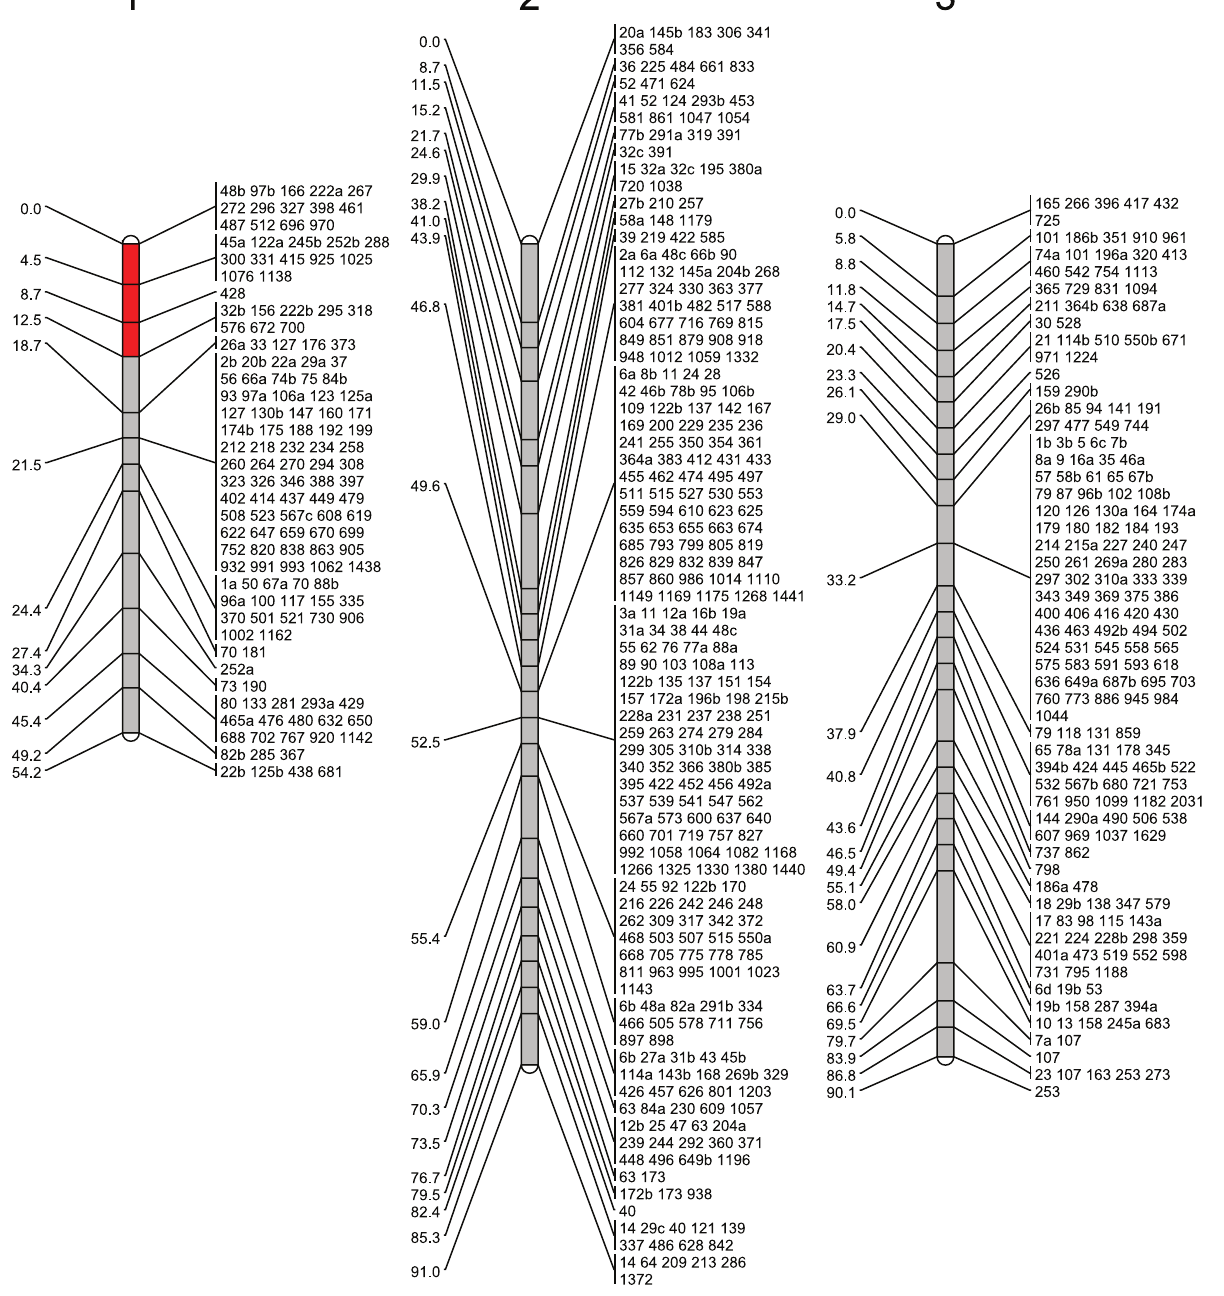
Figure 2. A linkage map of Ae.aegypti . The map was constructed using SNPs identified in RAD tag sequences. Positions in cM are indicated to the left of each linkage group. Scaffolds mapping to each position on the map are shown to the right of each linkage group and are named by the last 2– 4 digits of their supercontig ID number. The region linked with resistance to infection by B. malayi is highlighted in red. Scaffolds with suffixes a–d were previously misassembled and have been split and assigned new scaffold names (see Figure 1 and Table S2 for additional information).